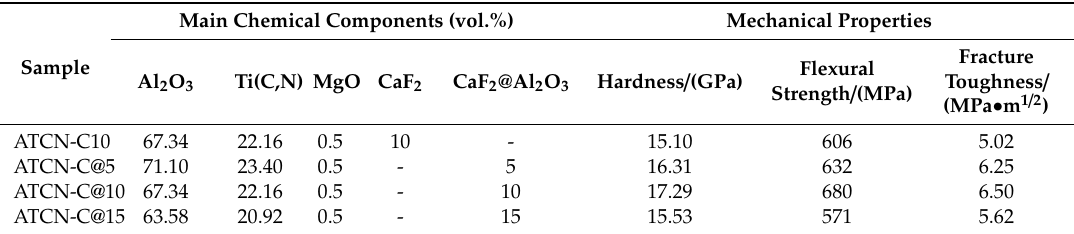
Table 2. Component ratio and mechanical properties of ceramic tools.